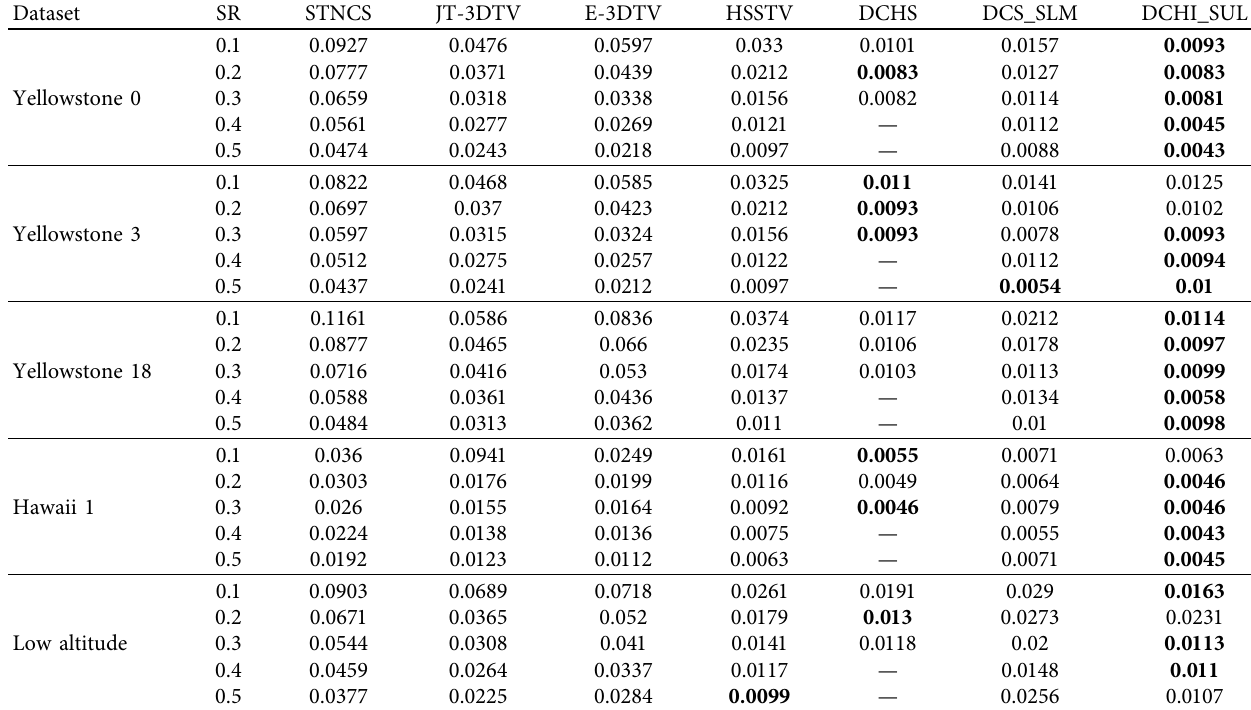
Table 3: MSAM comparison of all competing methods under different sampling rates on five datasets. Dataset